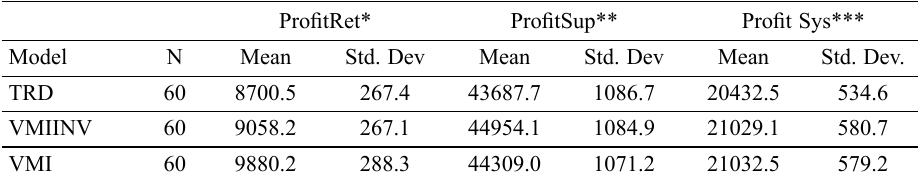
Table 5. Profit values of simulation